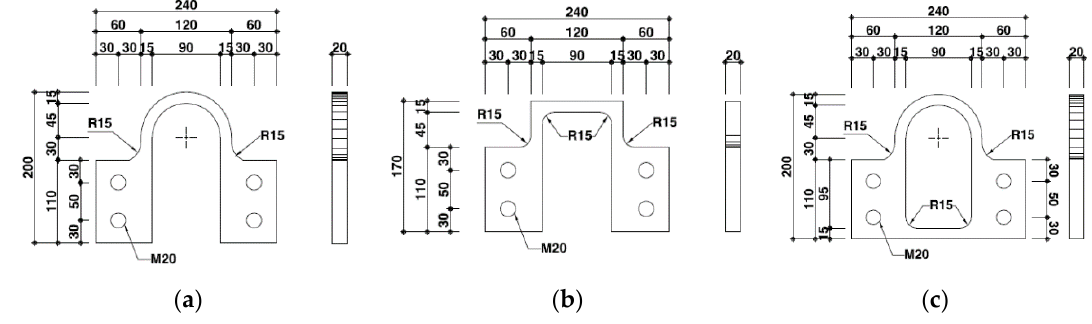
Figure 1. Details of steel dampers used in specimens (unit: mm): ( a ) SD1; ( b ) SD2; ( c ) SD3.